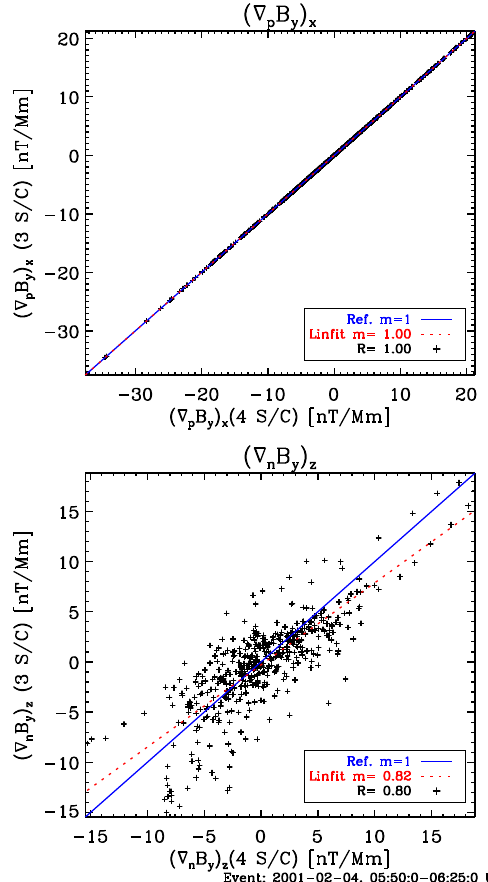
Fig. 2. 4 February 2001, 05:50–06:25UT: Scatter plots of the x component of ∇ p B y (upper panel) and the z -component of ∇ n B y (lower panel) in GSE coordinates, calculated using the stationar- ity assumption. Measurements during the time interval around 06:03 UT with small normal plasma flow speeds were excluded from the analysis. The horizontal axis represents the gradient com- ponent estimate using the reference four-point method. The vertical axis represents the estimate using our three-point method. The slope m of the linear regression (dotted red line) and the Pearson corre- lation coefficient R are given. The perfect match in the case of the ∇ p B y estimate is due to the construction of the planar reciprocal vectors.